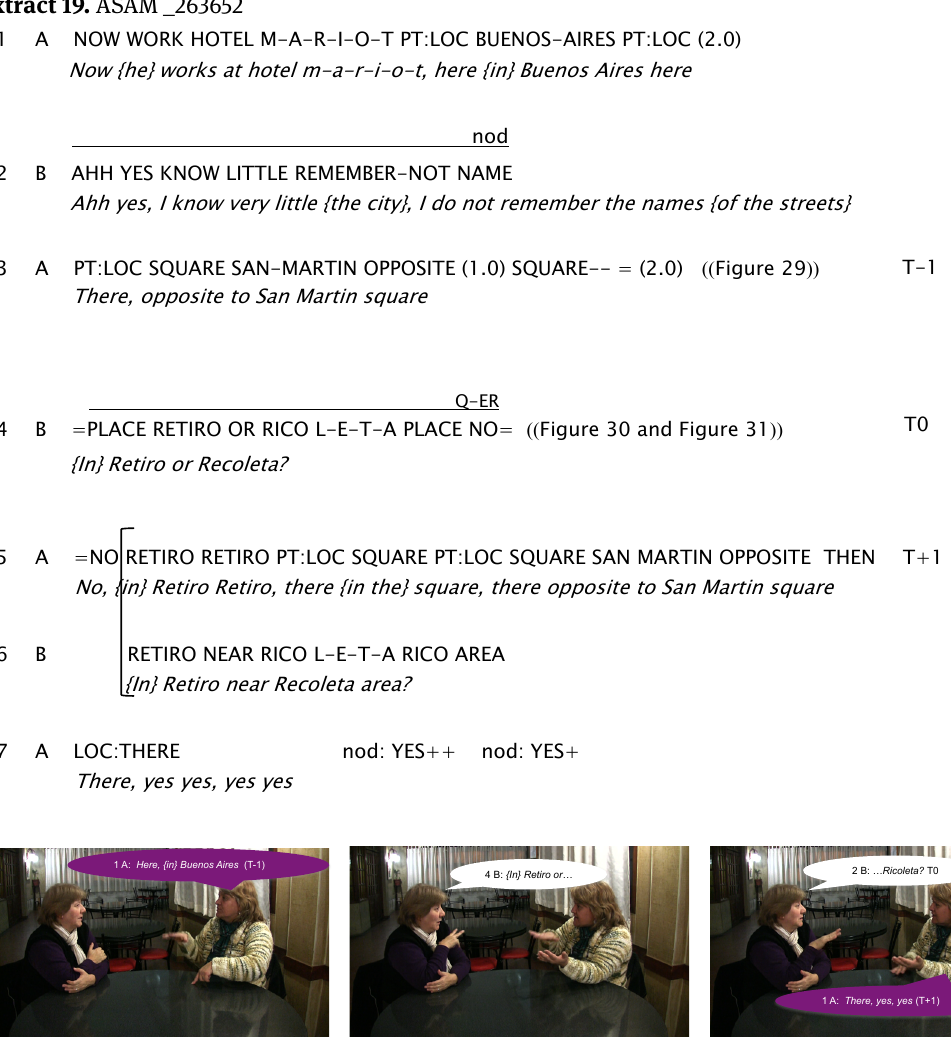
Figure 31. ‘ Recoleta?’, Person B offers the second alternative for candidate understanding combined with eyeb- rows raised, (line